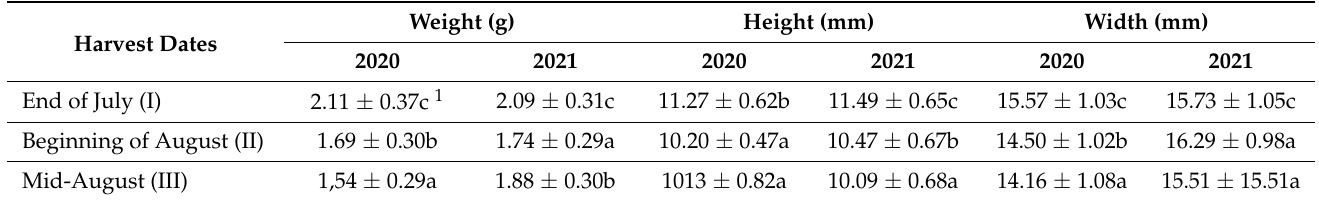
Table 11. Impact of harvest time on highbush blueberry fruit weight and their biometric parameters in 2020 and 2021.